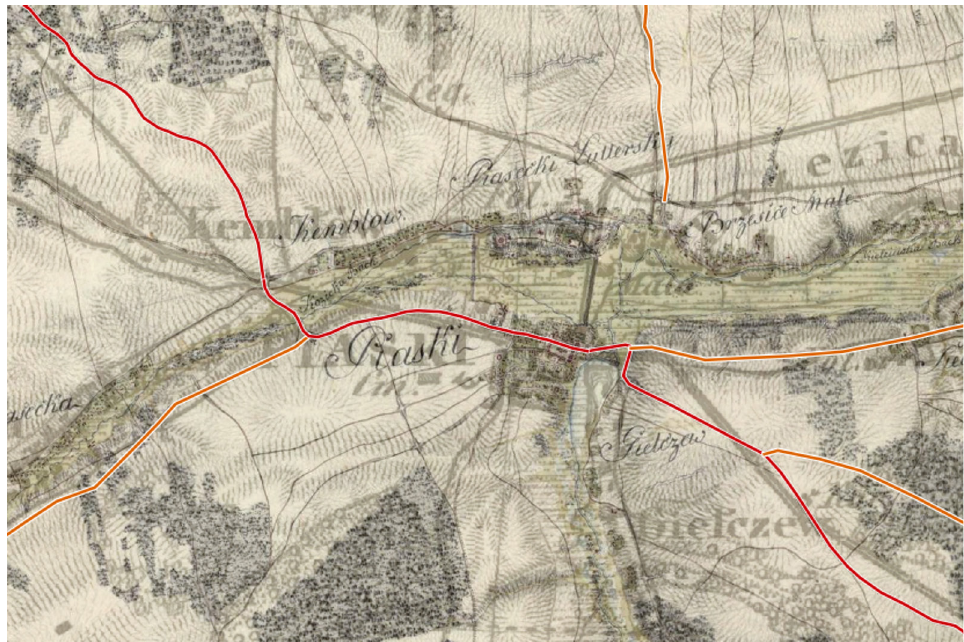
Fig. 3. Comparison of the road network layouts achieved by imposing Heldensfeld’s Map of Western Galicia (1:28,800, 1801–1804) (60% transparency) on the Quartermaster’s Map (1:126,000, 1843): (linear presentation of the geometry of the Western Galicia map’s roads – red line: postal roads